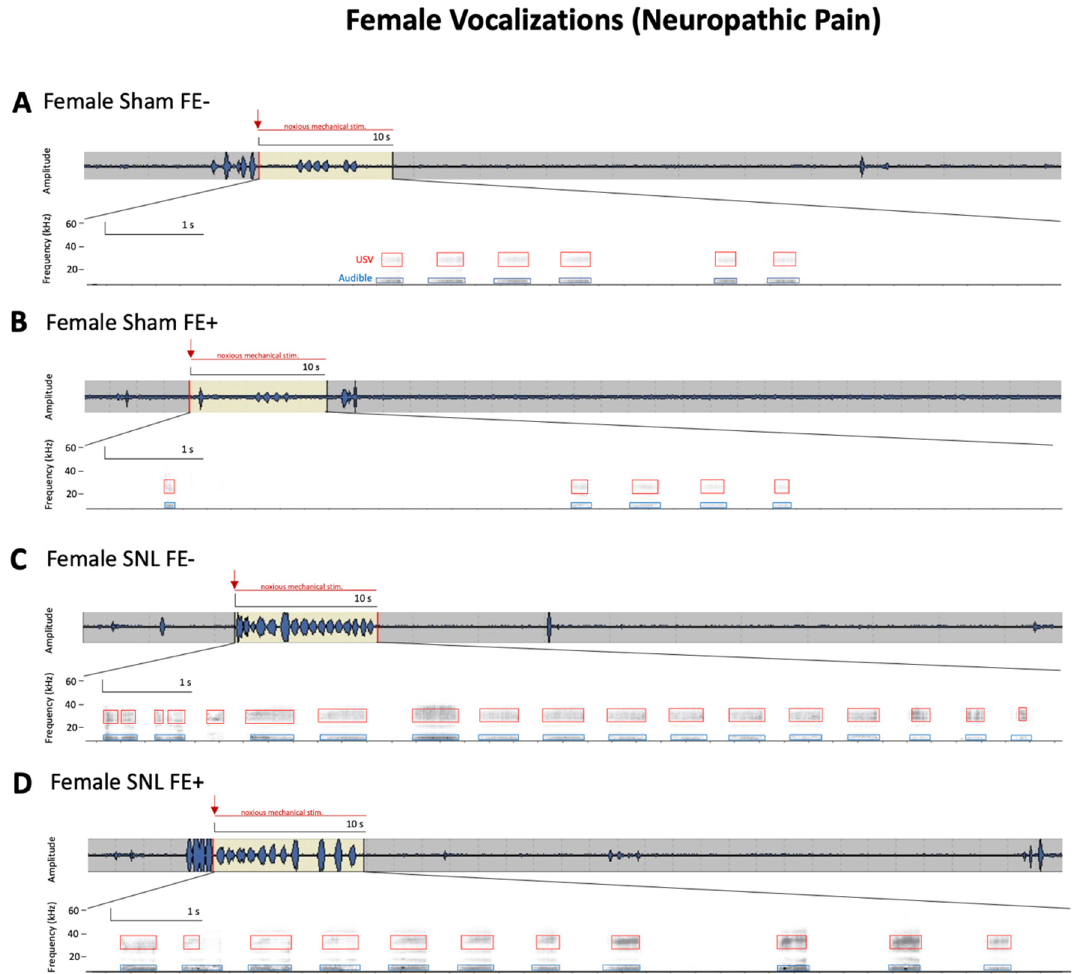
Figure 5. Representative audible and ultrasonic vocalizations from phenotyped female rats in the SNL model of neuropathic pain. Original real-time waveform and spectrogram recordings of vocalizations evoked in response to brief (10 s) noxious (1500 g/6 mm 2 ) mechanical stimulation of the affected hindpaw 4 weeks after induction of sham ( A , B ) or SNL ( C , D ) surgery in phenotyped female rats. For details, see Section 2.5.3. Mechanical stimuli were applied to the hindpaw in each recording period, as indicated by the highlighted yellow section of the waveform (upper panel, red arrow indicates initiation of noxious stimulus application); the total duration of the recording is 1 min. Boxes (events) in the spectrogram (lower panel) represent the presence of audible (blue; 20 Hz–16 kHz) and ultrasonic (red; 25 ± 4 kHz) vocalizations during the 10 s application of mechanical stimuli. Female FE − sham rats ( A ) showed more vocalization events in response to noxious stimulus than female FE+ sham rats ( B ). Female FE − SNL rats ( C ) showed more vocalization events in response to noxious stimulus than female FE+ SNL rats ( D ). FE: fear extinction; SNL: spinal nerve ligation; USV: ultrasonic vocalizations.